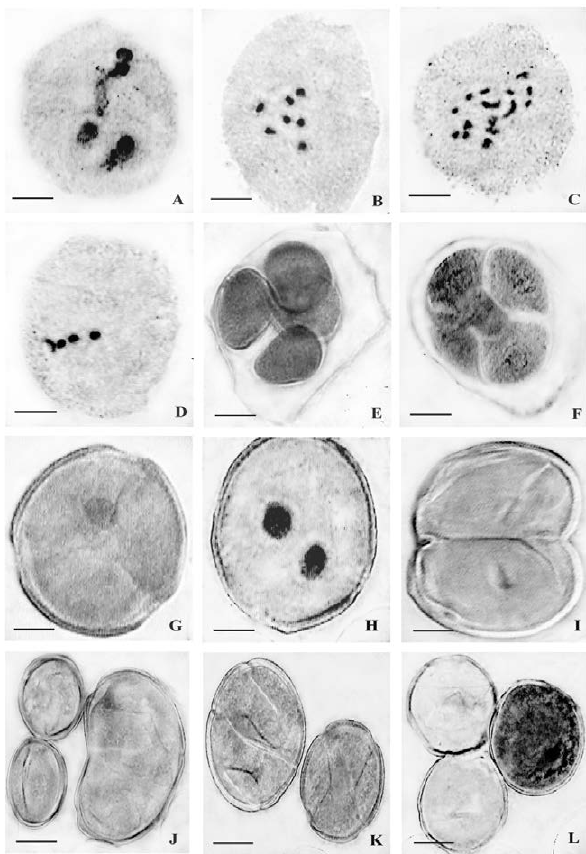
Fig. 2. Consequence of cytomixis on late meiotic phases and pol- len morphology. A: Supernumerary nucleoli; B: Normal PMC with seven bivalents; C: Syncyte with 14 bivalents; D: Hypoploid meio- cyte; E: Normal tetrad; F: Polyad; G: Normal fertile pollen; H: